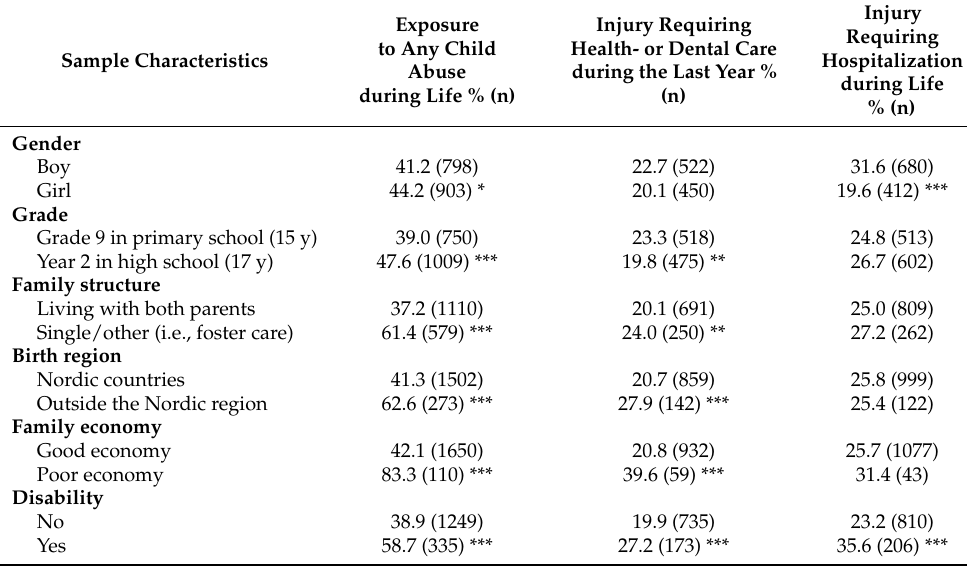
Table 2. Sociodemographic variables and the association with any child maltreatment during life, to unintentional injuries requiring health- or dental care during the last year and to unintentional injuries requiring hospitalization at some point during